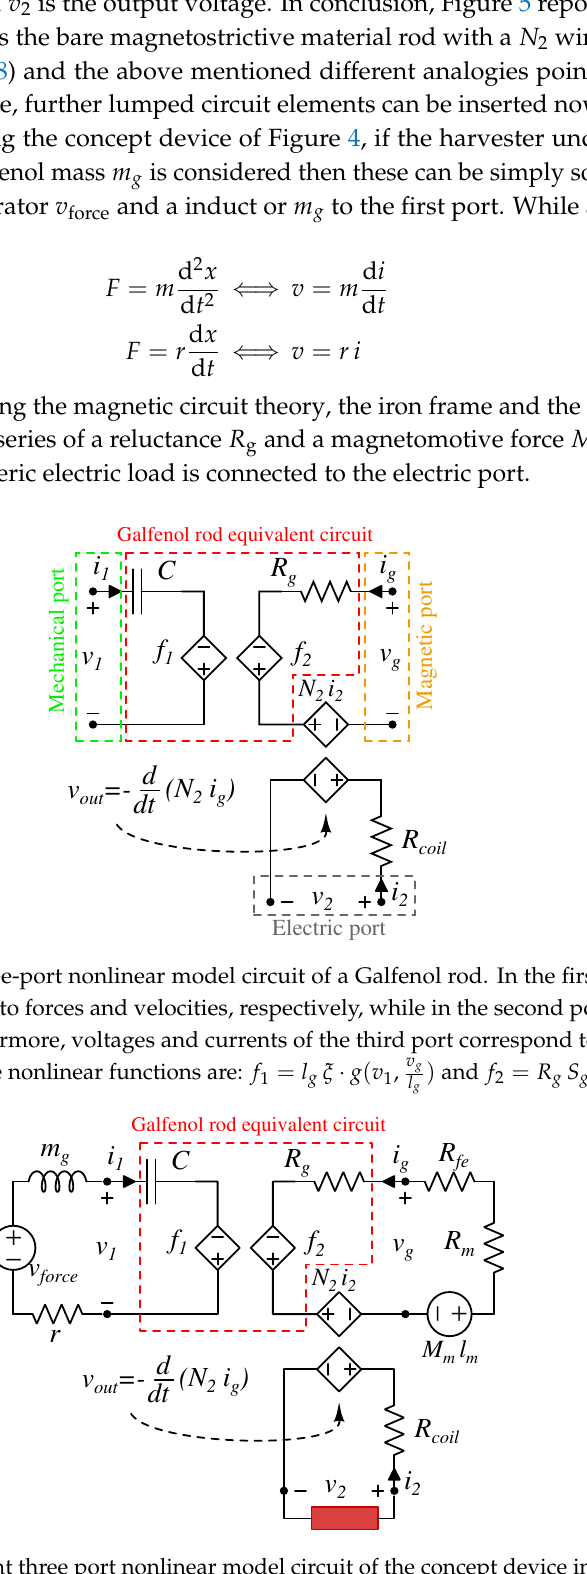
Figure 6. Equivalent three port nonlinear model circuit of the concept device in Figure